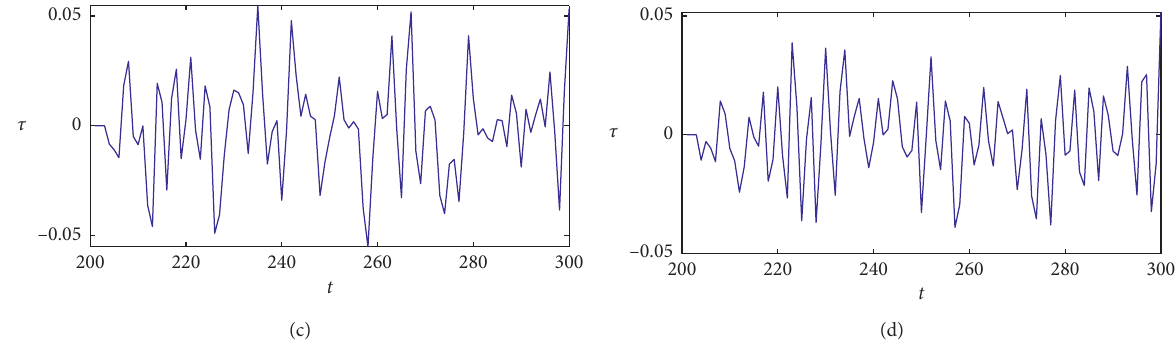
Figure 4: Output estimation errors of the four algorithms. (a) SG. (b) TI-SG. (c) MT-SG. (d)